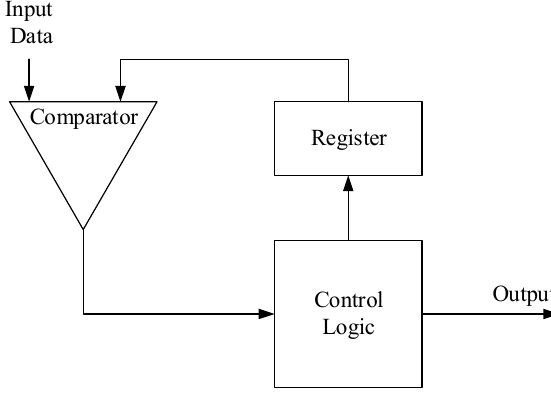
Figure 7. The structure of Pooler.